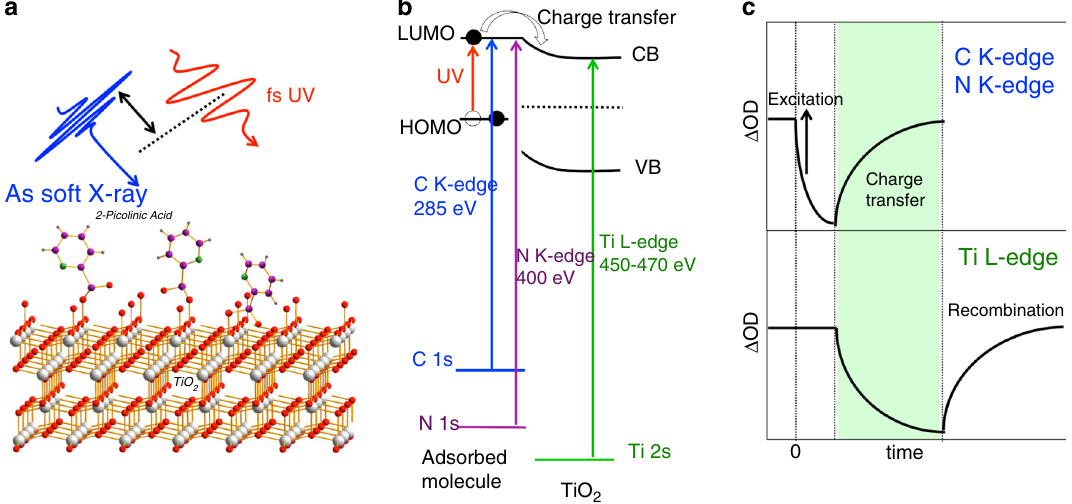
Fig. 4 Charge transfer in organic photovoltaic materials. a Schematics describing 2-picolinic acid adsorbed onto TiO 2 with femtosecond UV as the pump and attosecond SXR as the probe. b Energy diagram describing the electron transfer from LUMO of adsorbate to conduction band of TiO 2 . Schematics showing transitions from C K-edge and N K-edge to unoccupied states for adsorbate and those from Ti L-edge to conduction band for TiO 2 . c Expected attosecond transient-absorption signals at various probe energies (C K-edge, N K-edge, and Ti